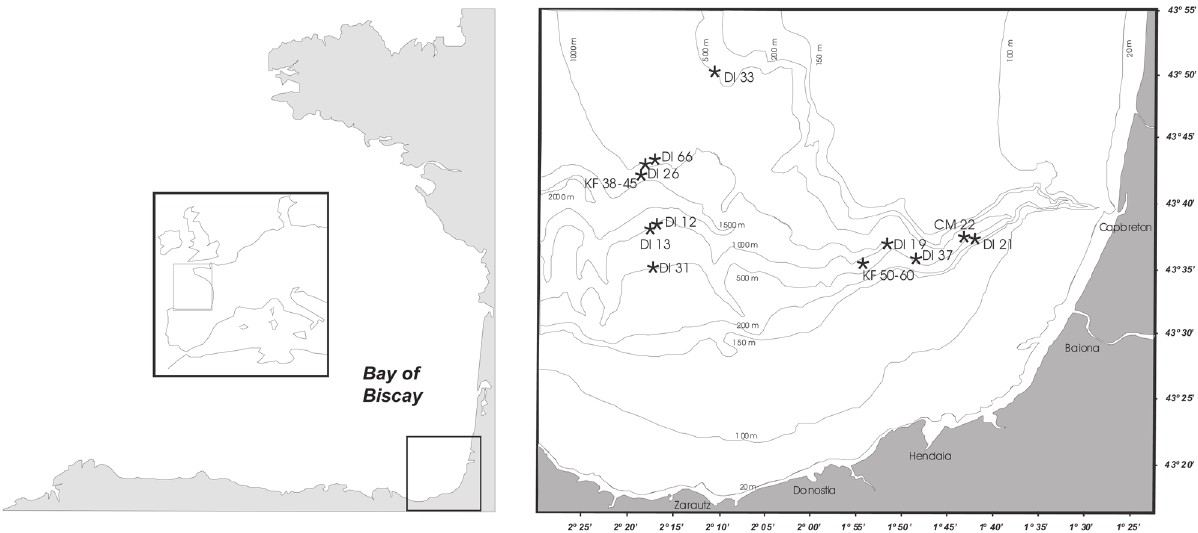
Fig . 1. – Map of capbreton canyon (bay of biscay) showing sampled stations with paraonid